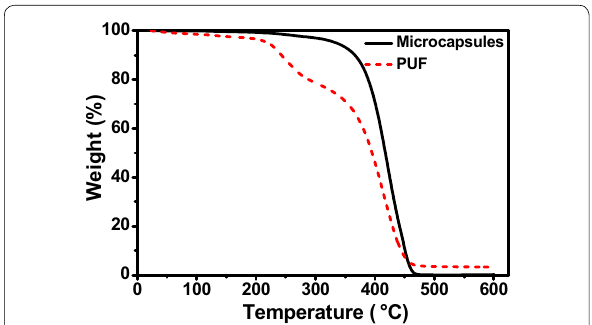
Fig. 3 TG curves of microcapsules and